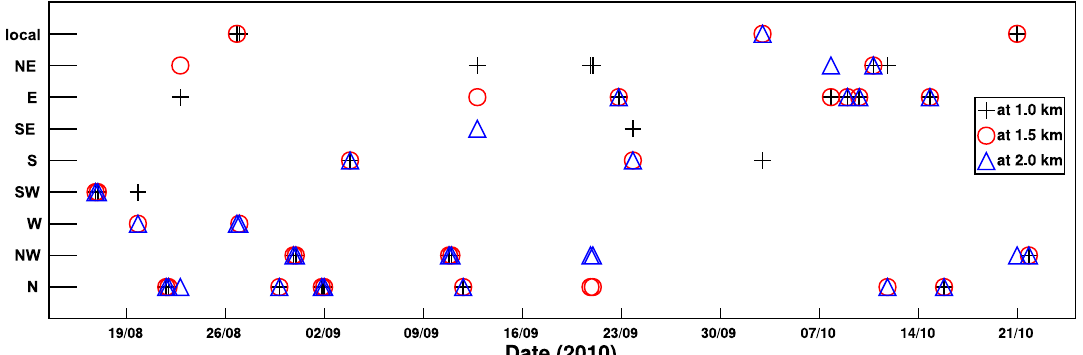
Figure 8. Origin of the air mass estimated from the backward trajectories using the Hybrid Single Particle Lagrangian Integrated Trajectory Model. Three different heights in the lower troposphere ( 1 . 0 km , 1 . 5 km and 2 . 0 km ) were